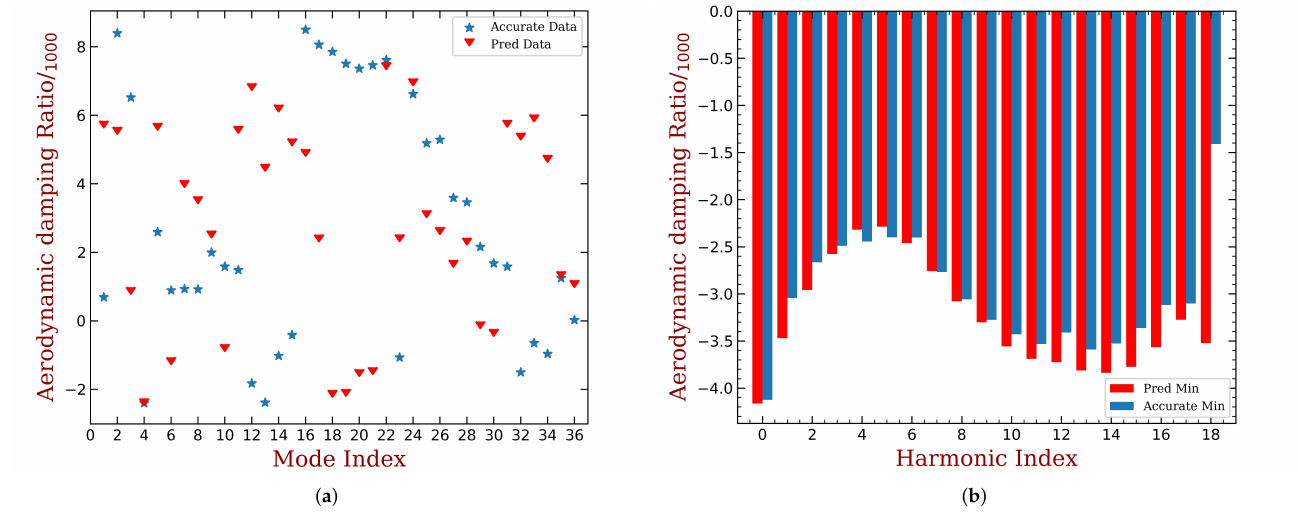
Figure 13. Predicted aerodynamic damping with wave and alternate patterns. The results labeled ’Pred Data’ are computed from Equations (31) and (32). ( a ) Damping ratio when h = 6, ( b ) least aeroelastic damping from h = 1 to h = 18.